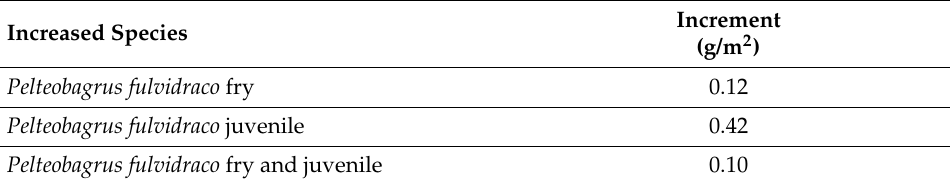
Table 6. Carrying capacity